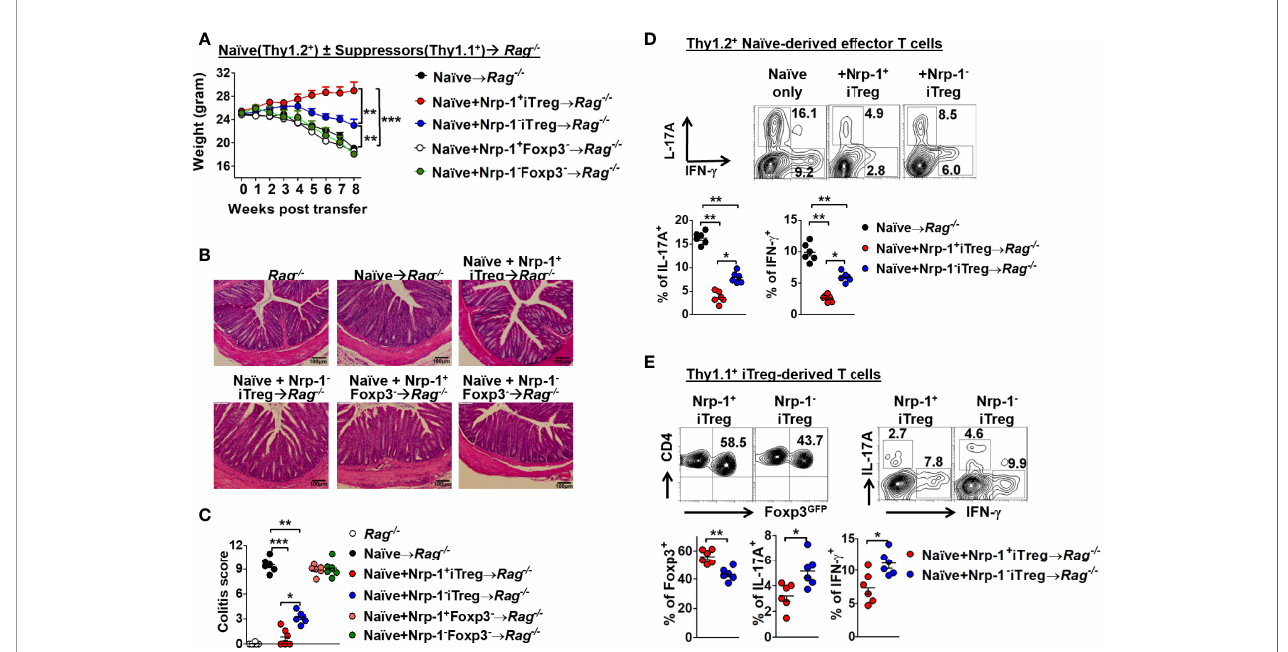
FIGURE 3 | Foxp3-GFP + Nrp-1 + iTreg had prior suppression than Foxp3-GFP + Nrp-1 - iTreg in vivo. C57BL/6 Rag1 -/- mice were transferred with 4x10 5 CD4 + CD25 - CD45RB hi T cells from C57BL/6 WT mice. Thy1.1 GFP + Nrp-1 + iTreg or GFP + Nrp-1 - iTreg or GFP - Nrp-1 + CD4 + T or GFP - Nrp-1 - CD4 + T cells were co-transferred with congenetic CD4 + CD25 - CD45RB hi T cells into rag1 -/- mice. (A) Representative weight loss curve, shown as a percentage of initial weight. (B, C) Intestinal in fl ammation scores for the colon. (D) IFN- g and IL-17a were detected in CD4 + T cell derived from Thy1.2 + naïve T cells in the mesenteric lymph node (MLN). (E) Foxp3-GFP, IFN- g , and IL-17a were detected in GFP + Nrp-1 + iTreg or GFP + Nrp-1 - iTreg from MLN; data were summarized (below). The data indicate the Mean ± SEM of 3 separated experiments (n=6 mice/group) (* p <0.05, ** p <0.01, *** p